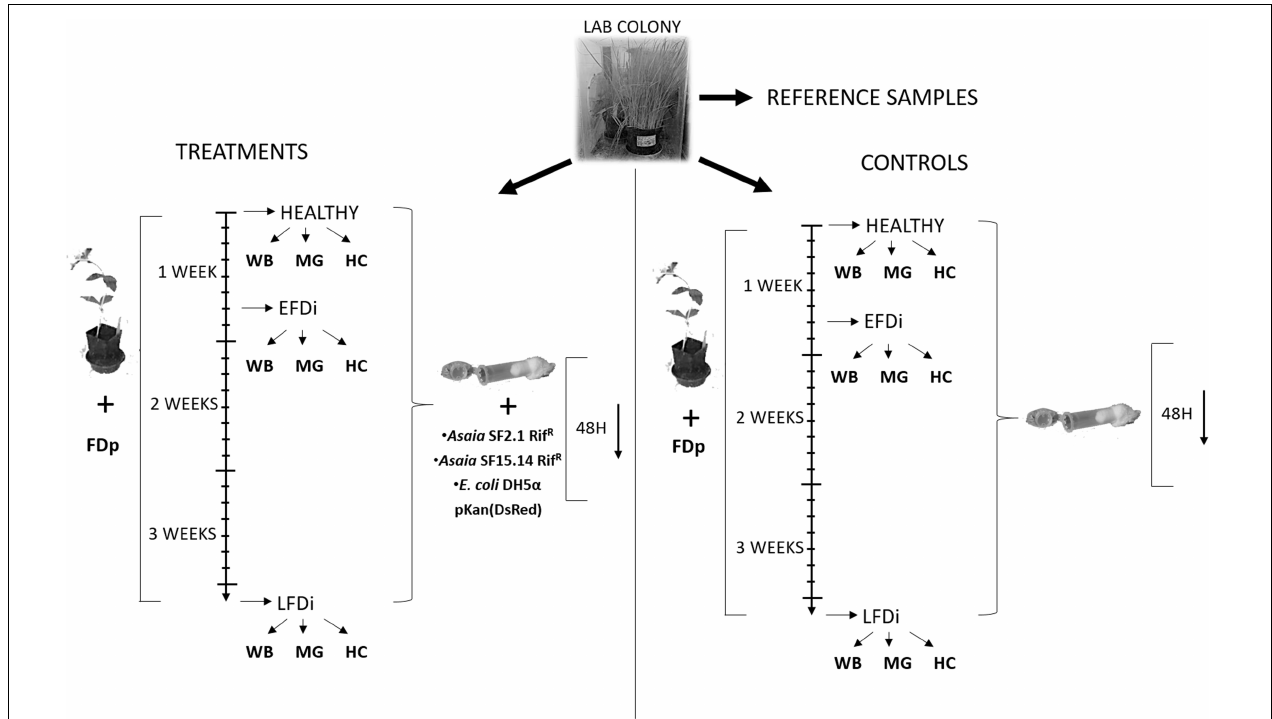
FIGURE 1 | Experimental set up of the trials for expression analysis of immune-related genes. Nymphs of E. variegatus were collected from our lab colony as reference samples for gene expression studies, or dedicated to treatments or controls. Insects of the healthy group were directly collected from the lab colony, while those of the EFDi group were exposed to FDp for 5 days and those of the LFDi group were exposed to FDp for 21 days. Afterward, leafhoppers used for treatments were fed either with Asaia SF15.14Rif R , Asaia SF2.1Rif R , or E. coli DH5 α pKan(DsRed) through artificial feeding systems, whereas specimens for the controls were maintained on a sterile sugar diet. Within each group whole insect bodies (WB), midguts (MG), and hemocytes (HC) were taken